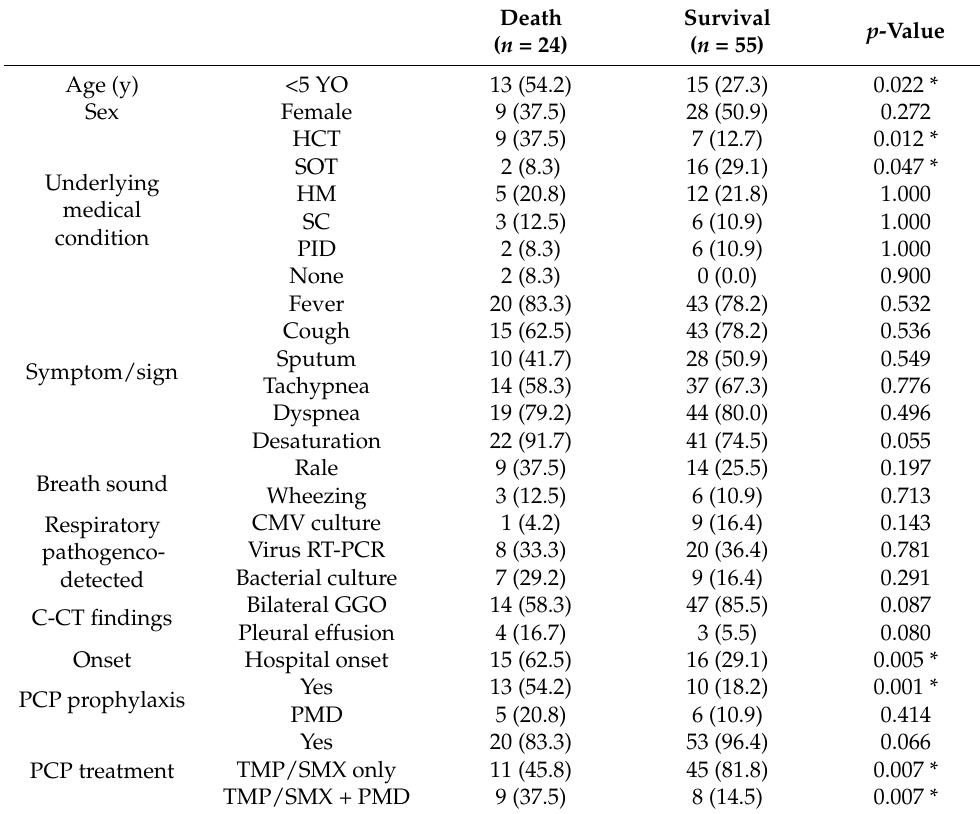
Table 2. Univariate analyses for risk factors of mortality in clinical PCP, n (%).